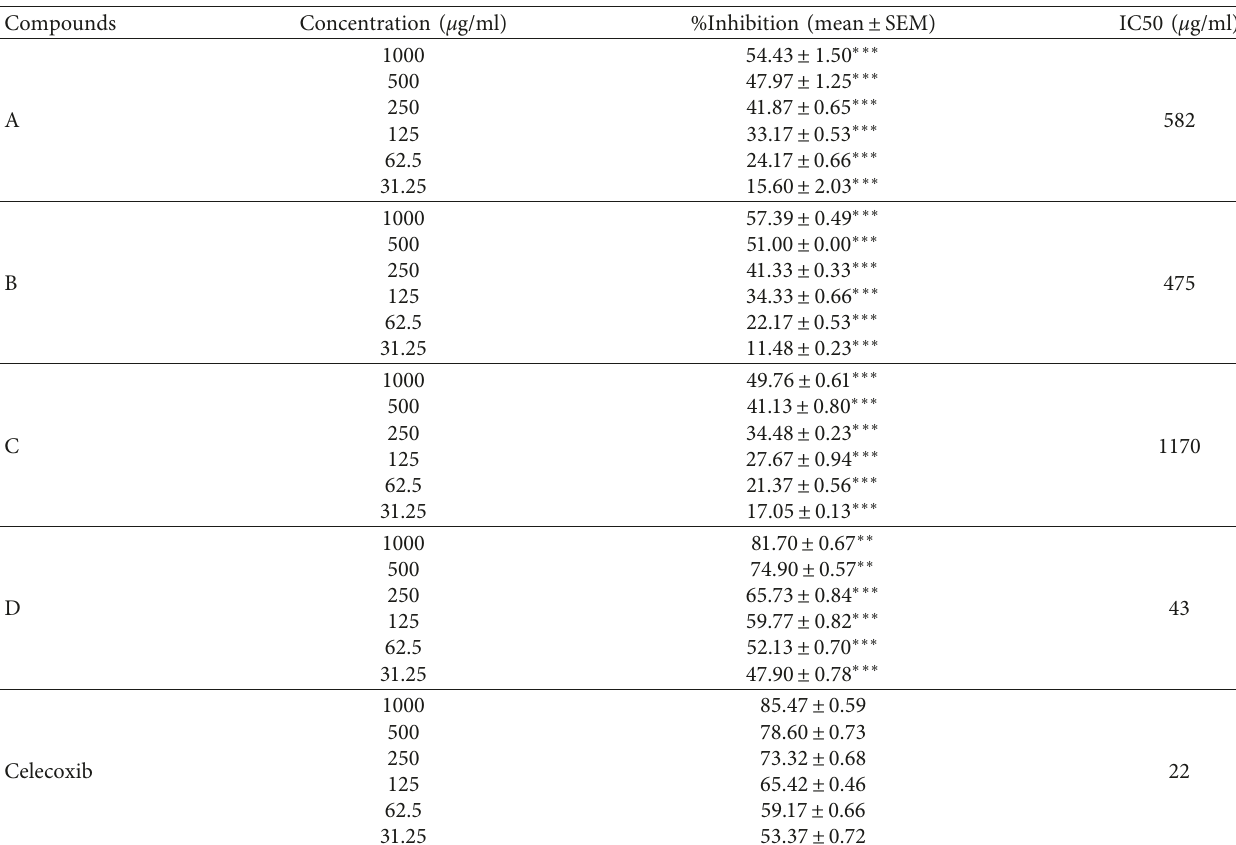
Table 1: COX-2 inhibitory potentials of the tested compounds